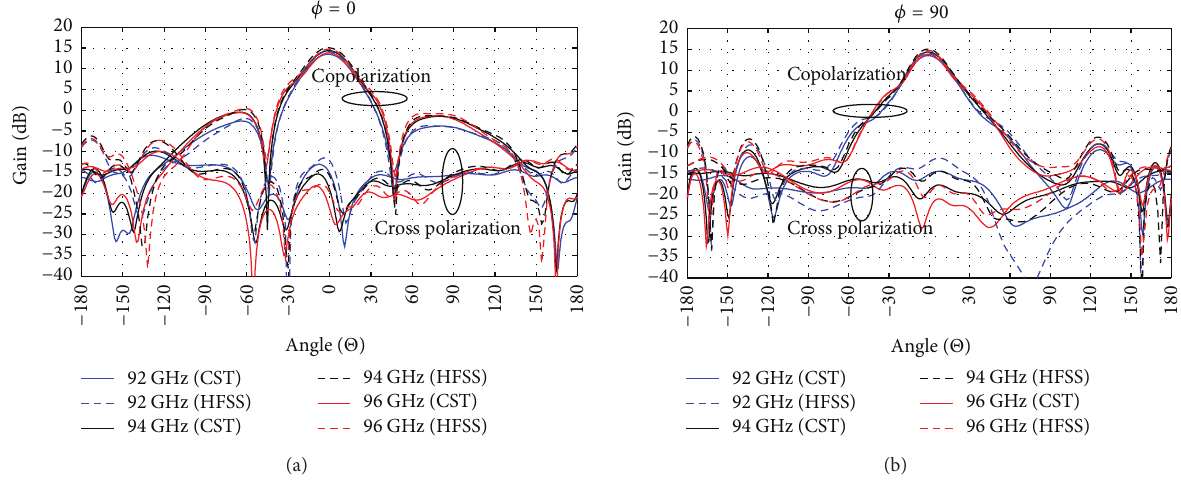
Figure 13: Simulated (a) E-plane and (b) H-plane radiation characteristics of superstrate antenna for an optimised superstrate dimension × 2𝜆 ℎ = 0.6𝜆 𝑡 = 0.127 𝑆 = 2𝜆 0 0 , height 0 , and thickness